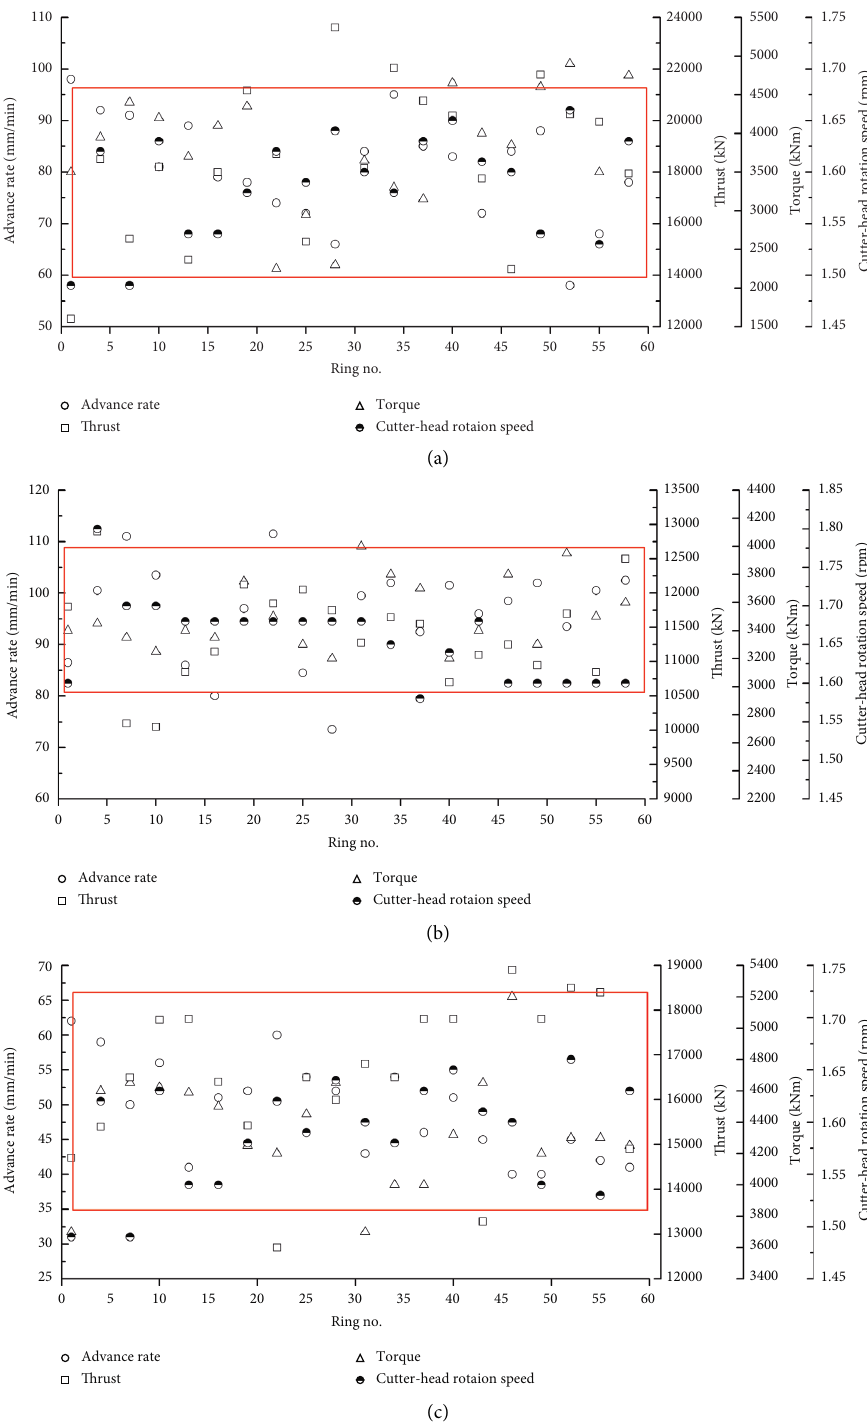
Figure 10: Comprehensive performance of (a) EPB1, (b) EPB2, and (c)